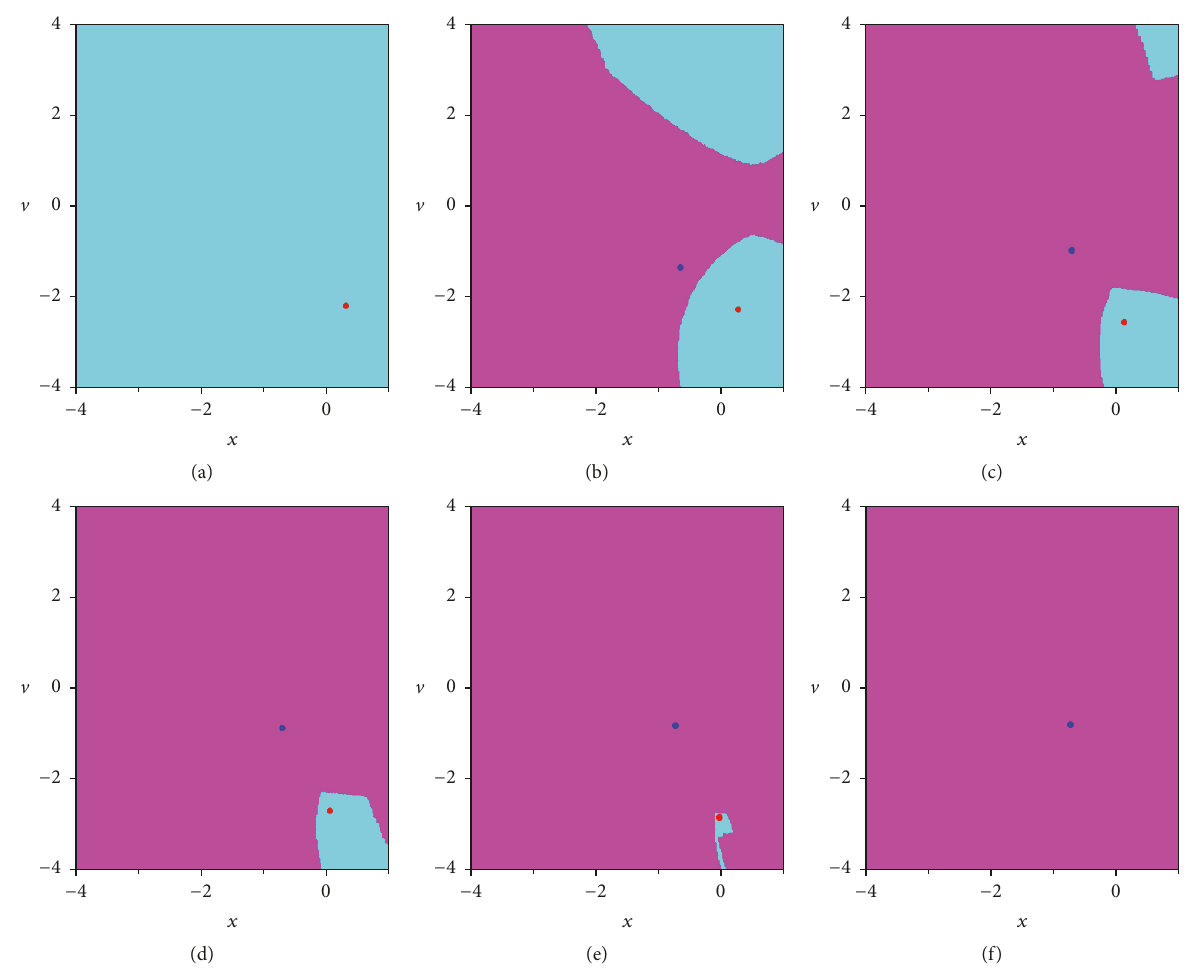
Figure 6: Evolution of the basins of attraction for the impact oscillator with bilinear damping obtained for 𝜔 = 0.8 , 𝑒 = 1 , 𝜉 1 = 0.05 , 𝜉 2 = 0.04 , 𝑟 = 0.7 , (a) 𝑎 = 1.60 , (b) 𝑎 = 1.65 , (c) 𝑎 = 1.70 , (d) 𝑎 = 1.95 , (e) 𝑎 = 2.05 , and (f) 𝑎 = 2.10 . Here the period-1 orbit with one impact per period shown in red has a cyan basin, and the period-1 orbit with two impacts per period shown in blue has a magenta